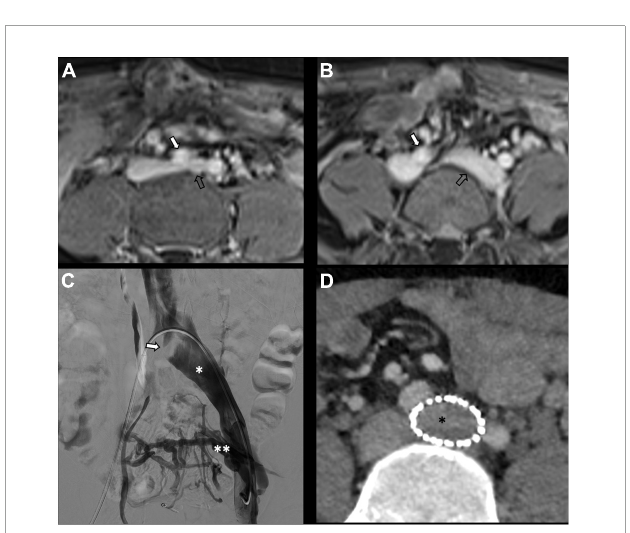
FIGURE5 Type IIa pelvic varices in a 30 yo male due to May-Thurner syndrome. (A,B) MR phlebography shows left common internal iliac vein (open arrow) compressed by the right common iliac artery (white arrow). (C,D) Conventional and computed tomography (CT) phlebography show dilated left common iliac vein (single white asterisk) with left-sided pelvis varices (double white asterisks), treated with stenting (single black